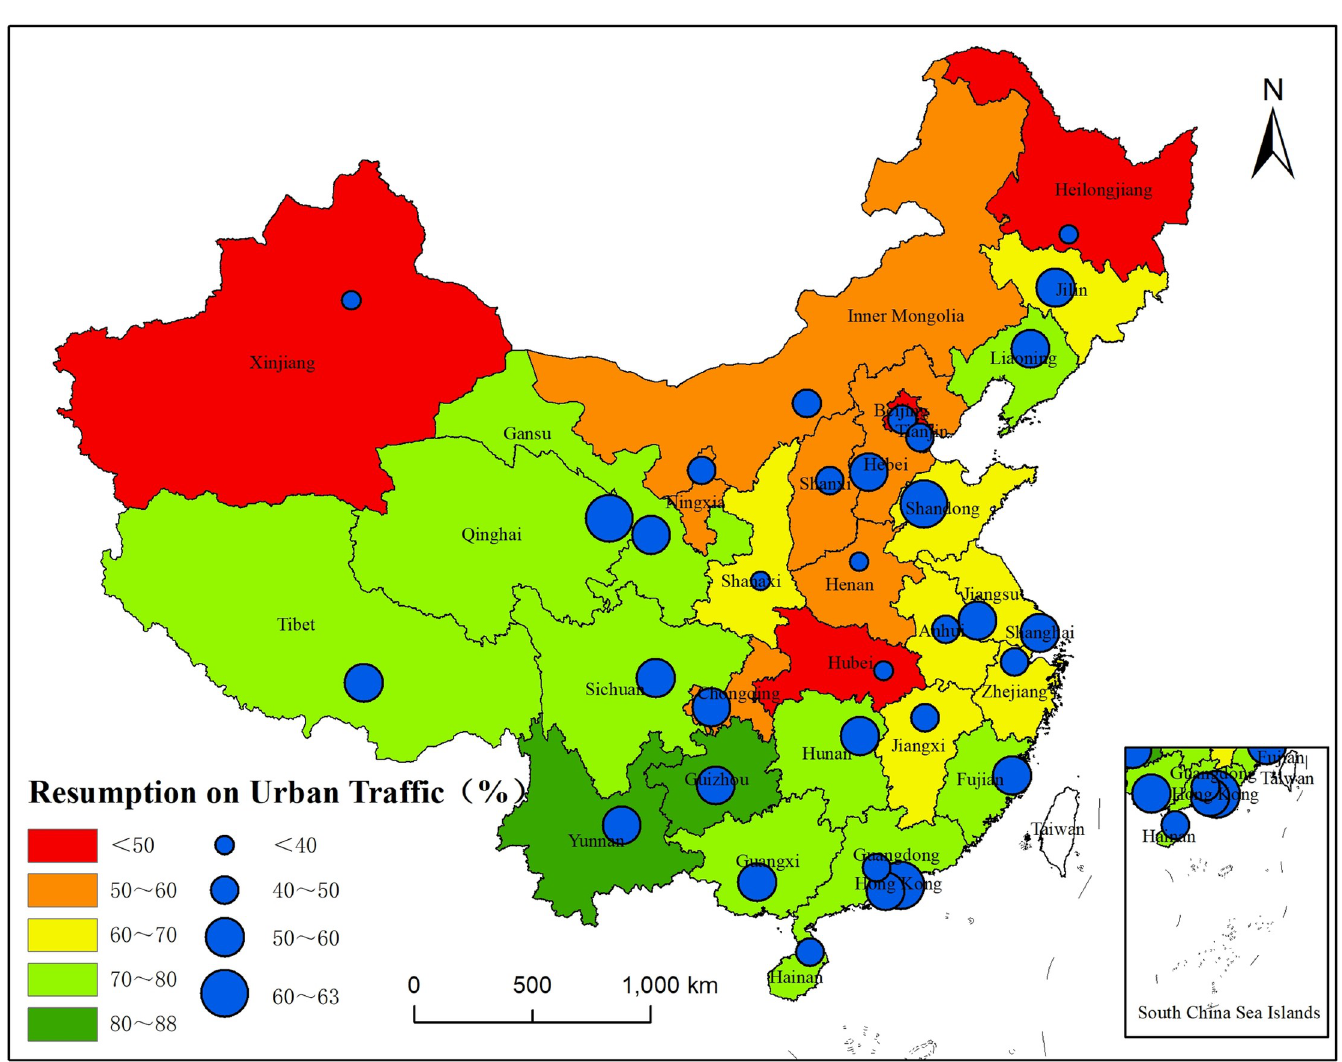
Fig 5. Distribution of the resumption of urban traffic in provinces, municipalities and capital cities.